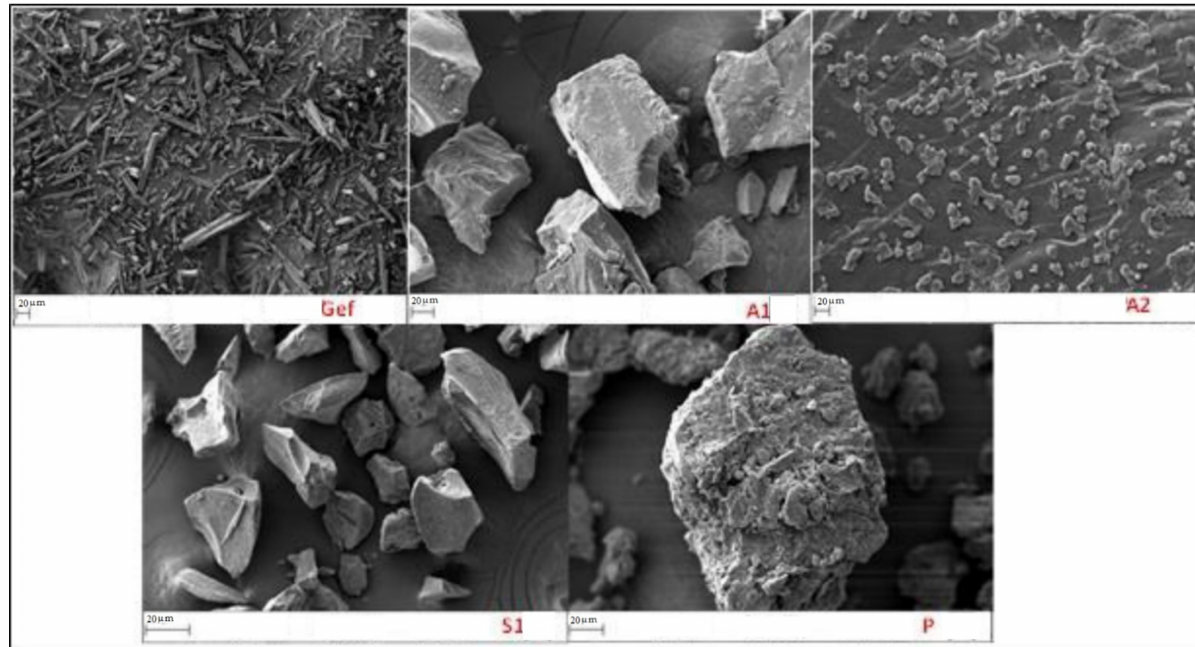
Figure 3. Scanning electeron microscope (SEM) images of pure Gefitinib (Gef) and various SDs (A1-F, A2-F, S2-F, and P-F) prepared using fusion method.